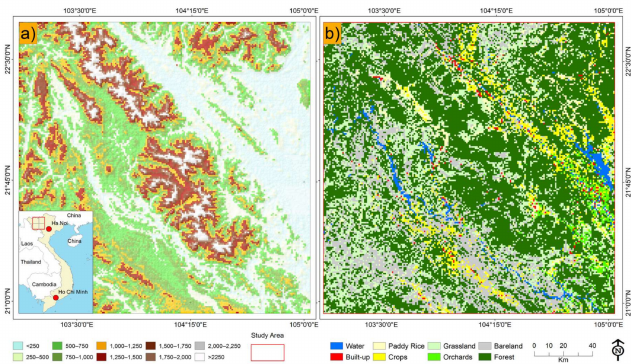
Figure 1. Location of the study area in northwest Vietnam. ( a ) Elevation range from advanced spaceborne thermal emission and reflection radiometer (ASTER) global Digital Elevation Model (DEM) and ( b ) land cover from Japanese Aerospace Exploration Agency (JAXA) distribution in the study